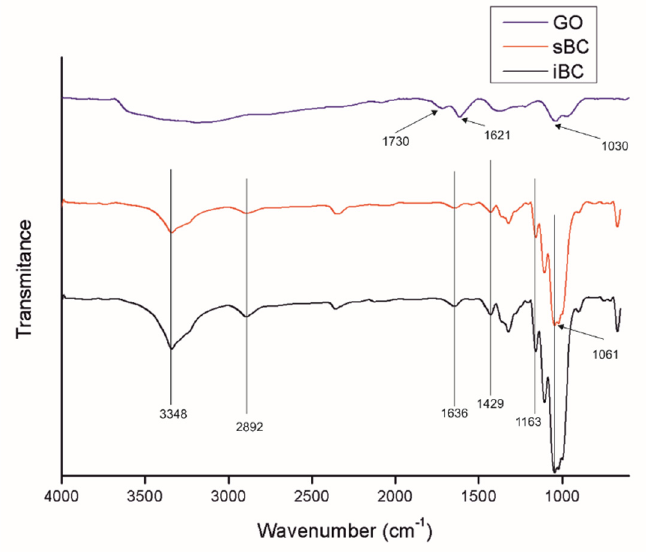
Figure 9. FTIR spectra of GO and neat BC produced by K. intermedius and K. sucrofermentans . The spectra range from 4000 cm − 1 to 650 cm − 1 .